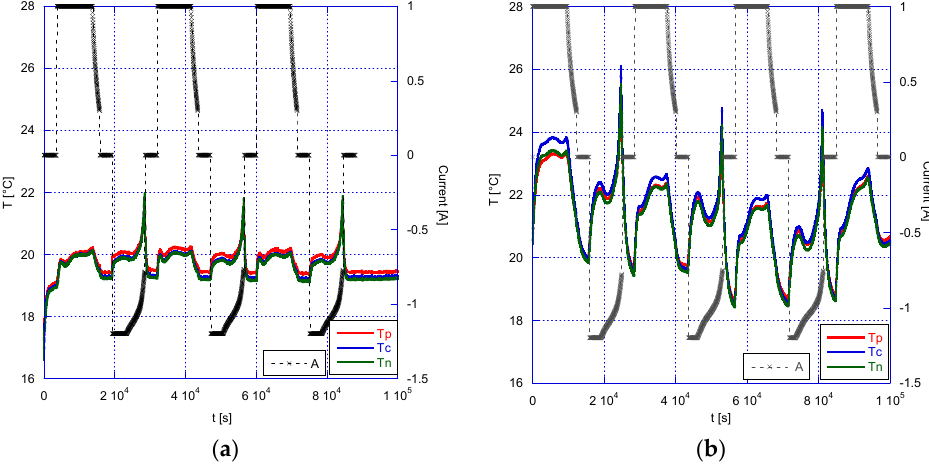
Figure 6. Graphite anode cells; DOD% = 110%. Temperature trend during the capacity test: ( a ) before and ( b ) after the overdischarge abuse.